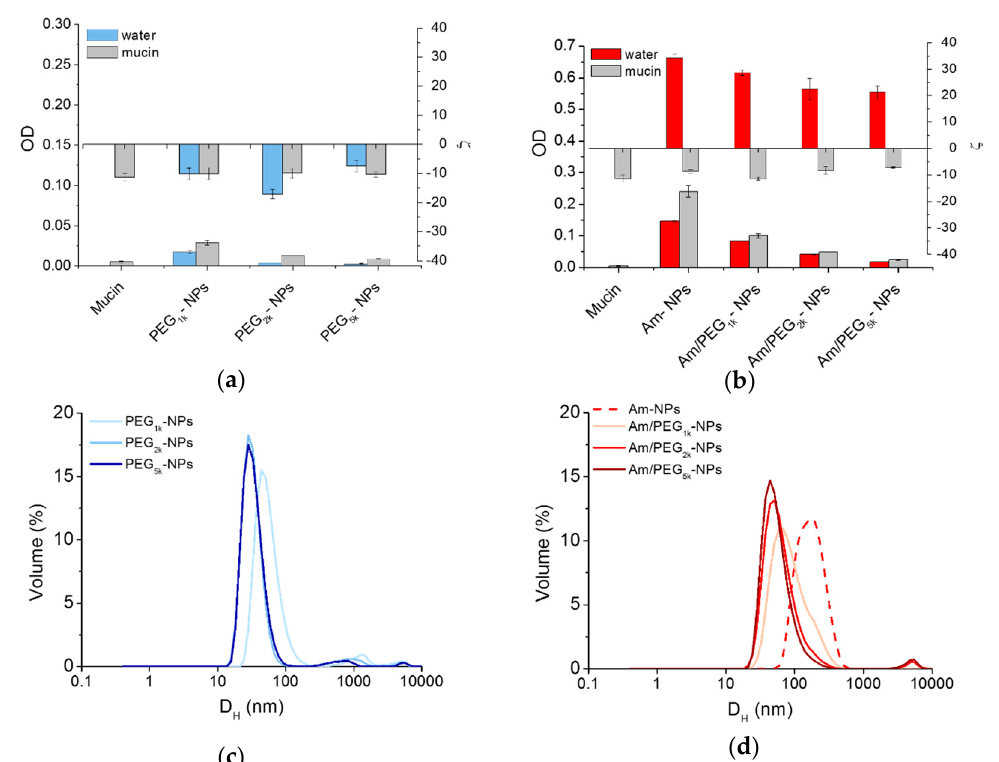
Figure 5. Interaction of NPs with mucin. Scattering of PEG-NPs ( a ) or Am-NPs and Am / PEG-NPs ( b ) in water or in a mucin water dispersion (0.08% w / v) (NPs = 0.5 mg / mL). Data are an average of triplicate measurements ± SD. Representative size distribution curves of PEG-NPs ( c ) or Am-NPs and Am / PEG-NPs ( d ) in a mucin water dispersion (0.08% w / v) (NPs = 0.5 mg / mL).